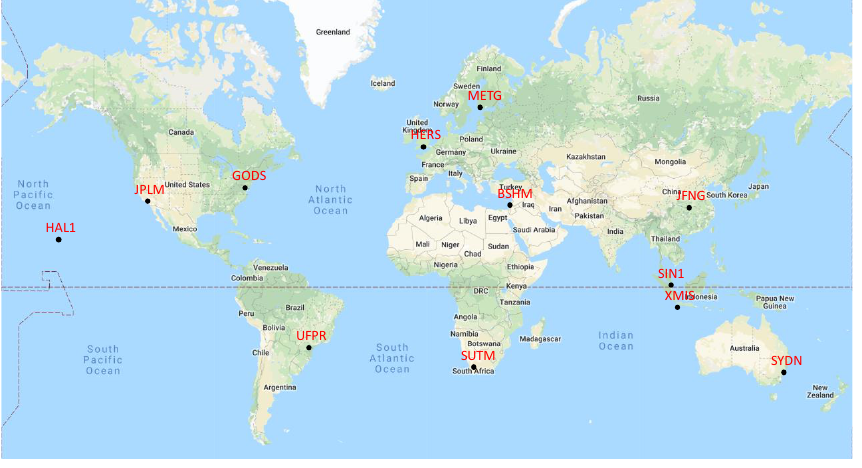
Figure 9. Distribution of observation stations. The black points are station locations, and the red words are station names.